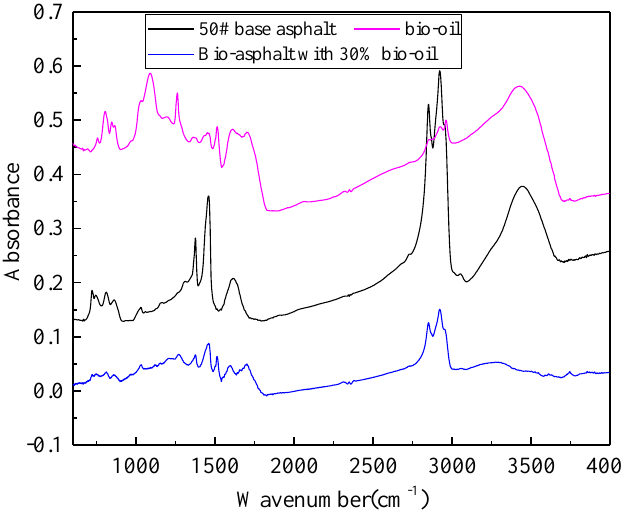
Figure 15. FTIR spectra of three kinds of binders.